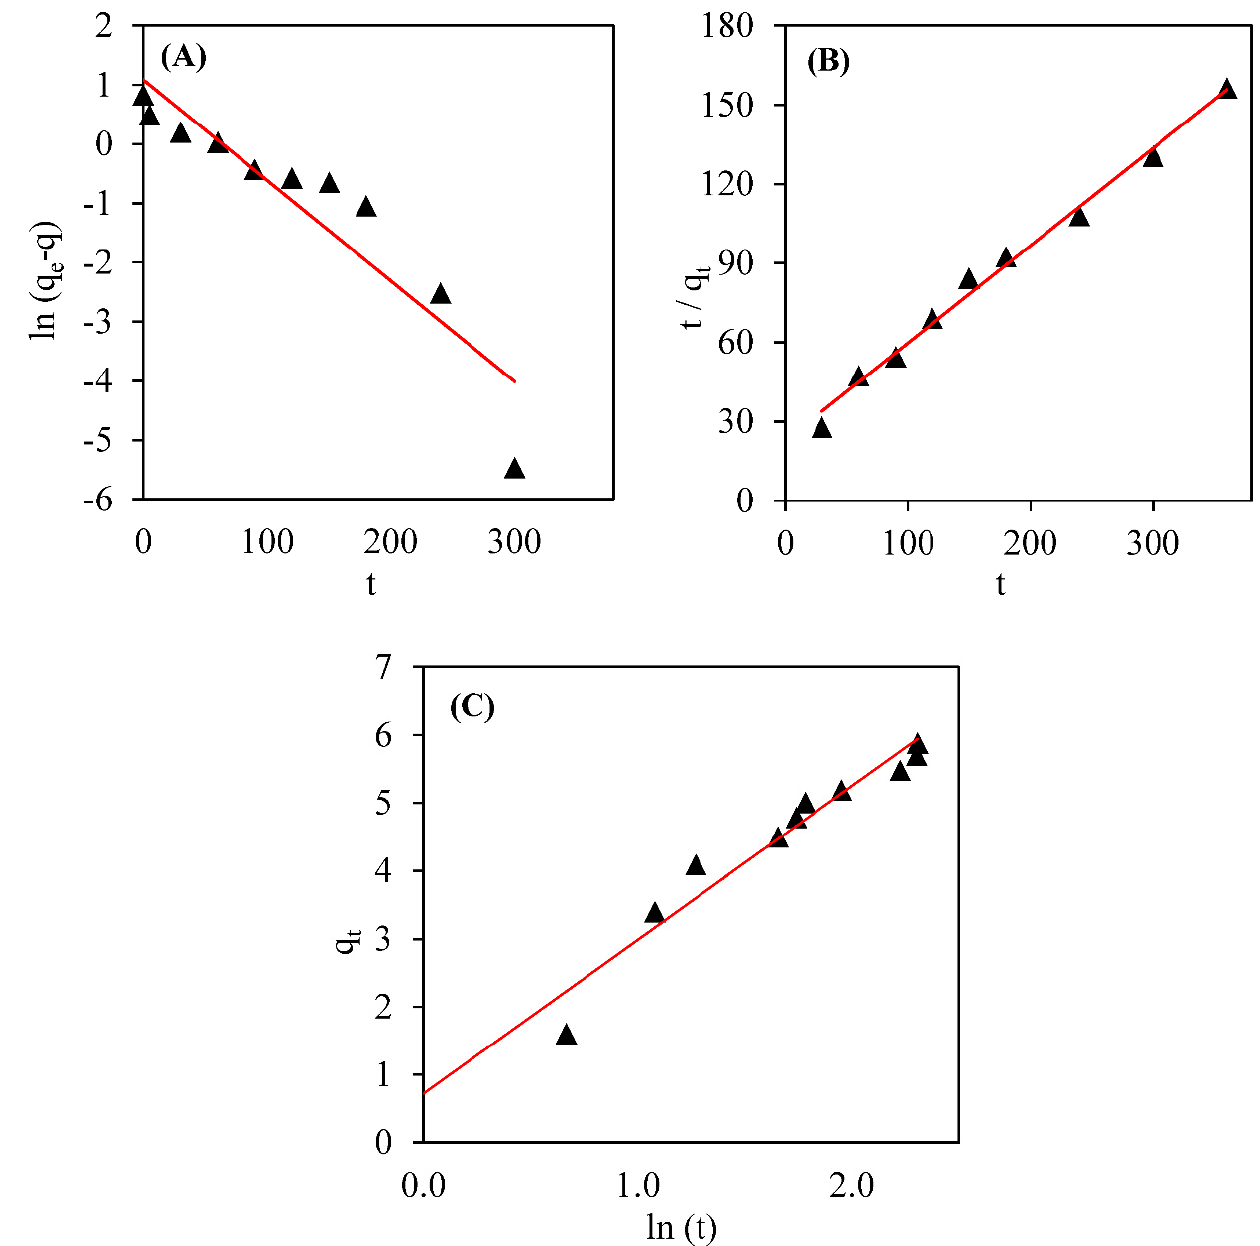
Figure 4. Linear plots of the ( A ) pseudo-first order kinetic model, ( B ) pseudo-second order kinetic model, and ( C ) Elovich model for ciprofloxacin adsorption by the biosorbent made of pecan shells.